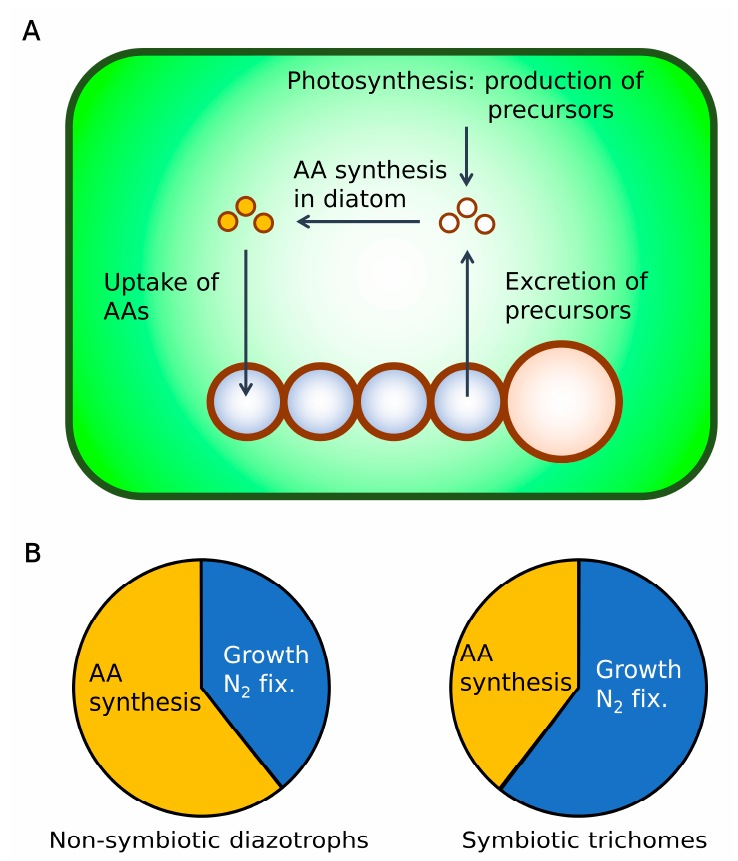
Figure 6. Hypothetical view of molecular exchanges between the diatom and the trichome and the protein allocation of the trichome. ( A ) Molecular exchanges between diatom and the trichome. Green space: cytoplasm in the diatom. Blue circles: vegetative cells. Orange Space: heterocysts. ( B ) The idealized protein allocations of non-symbiotic diazotrophs and symbiotic trichomes. Here, only proteins (enzymes) for amino acid (AA) synthesis and growth and N 2 fixations (N 2 fix.) are considered for conceptual simplicity. By having the diatom process molecules, symbiotic trichomes would be able to allocate more proteins for growth and N 2 fixation, allowing the cells to grow and fix N 2